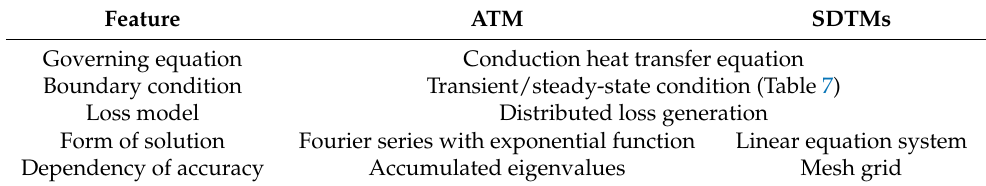
Table 10. Comparison of characteristics of ATM and SDTM